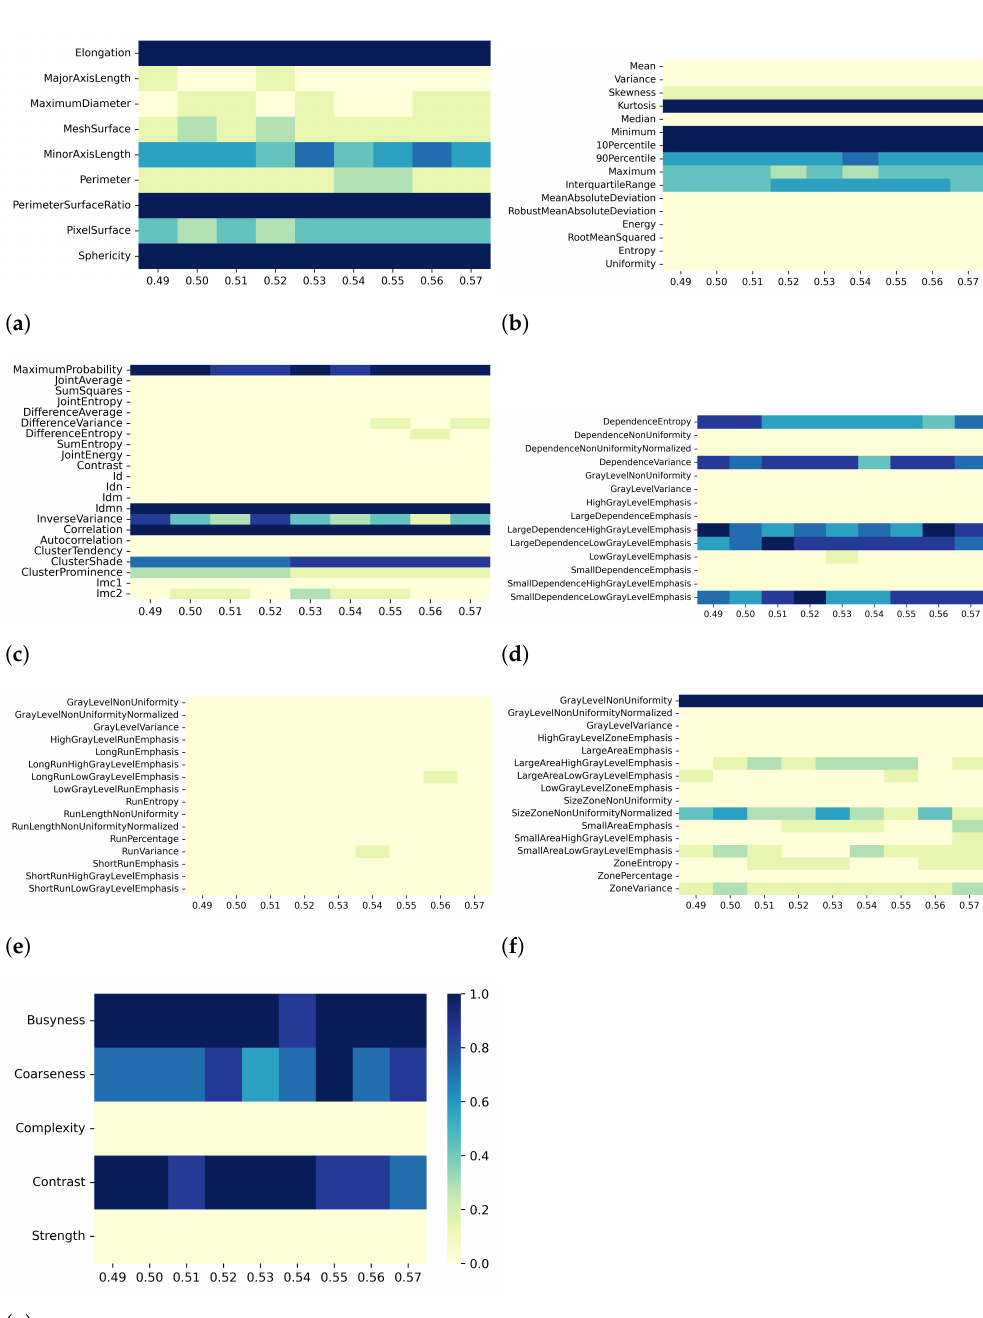
Figure 6. Heatmaps of remaining features from T2 maps after PCC-based dimensionality reduction for effect A (varying resampling voxel size, with fixed discretization bin width (ms)). The radiomic features are separated in classes: ( a ) 2D shape, ( b ) first order, ( c ) GLCM, ( d ) GLDM, ( e ) GLRLM, ( f ) GLSZM, ( g )